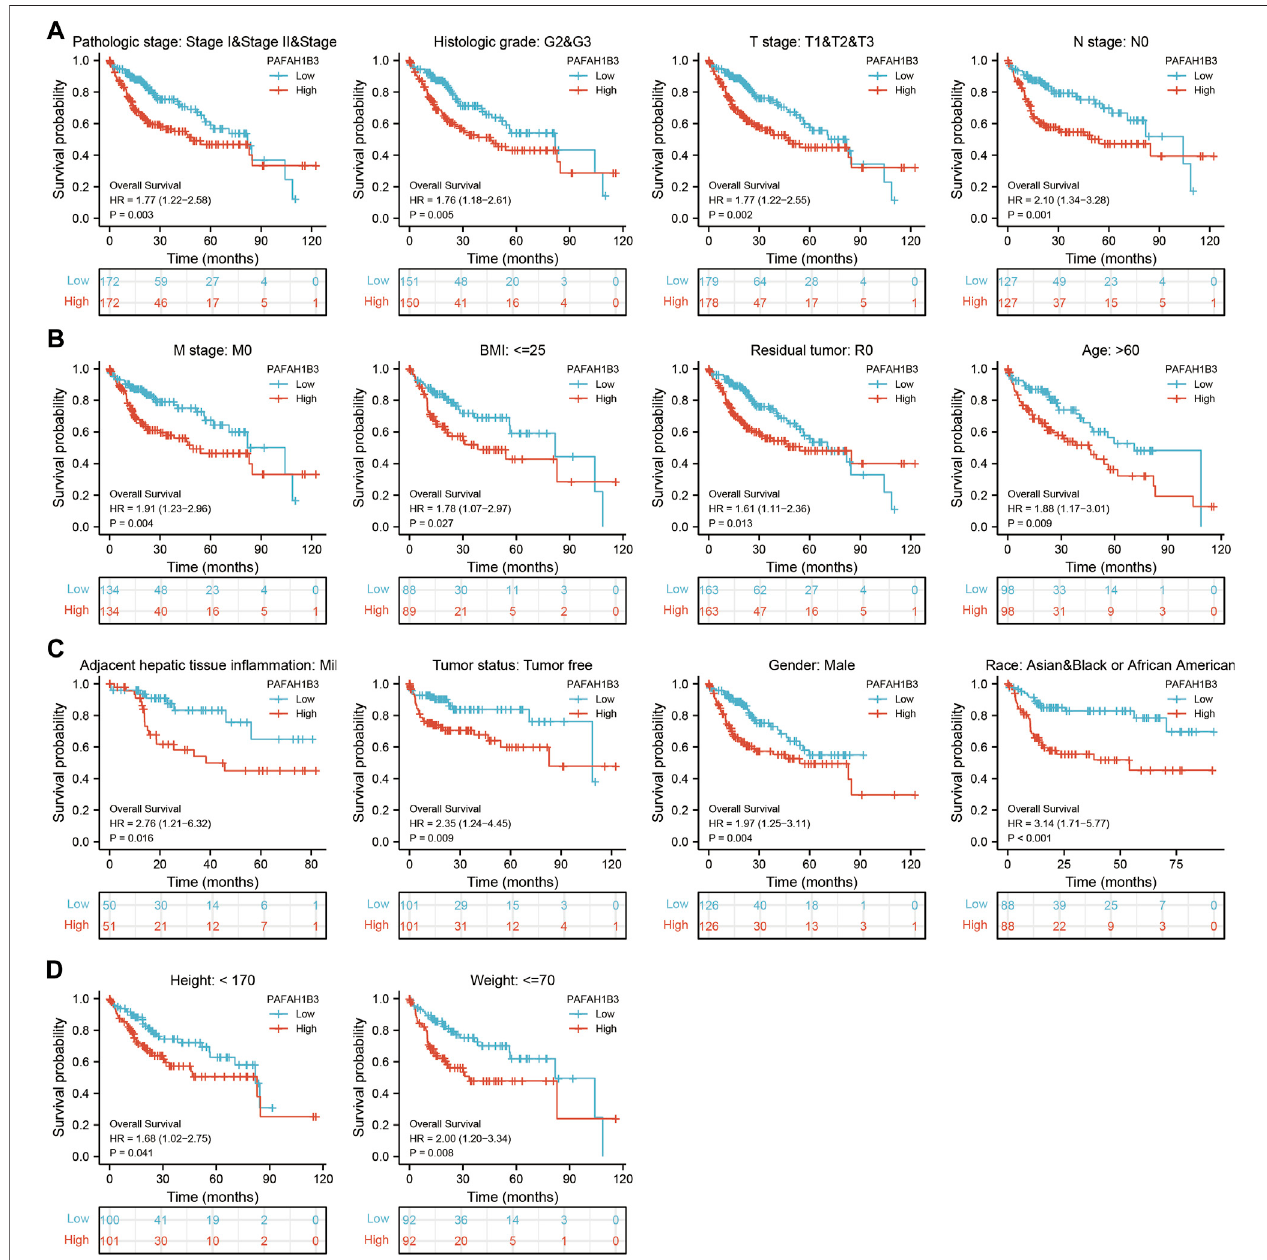
FIGURE 8 | PAFAH1B3 Is Correlated With Prognosis in LIHC. (A – D) The correlation between PAFAH1B3 and OS in different clinical subgroups of LIHC, including pathologic stage, histologic stage, TNM stage, residual tumor, gender, age, adjacent hepatic tissue in fl ammation, height, and weight.